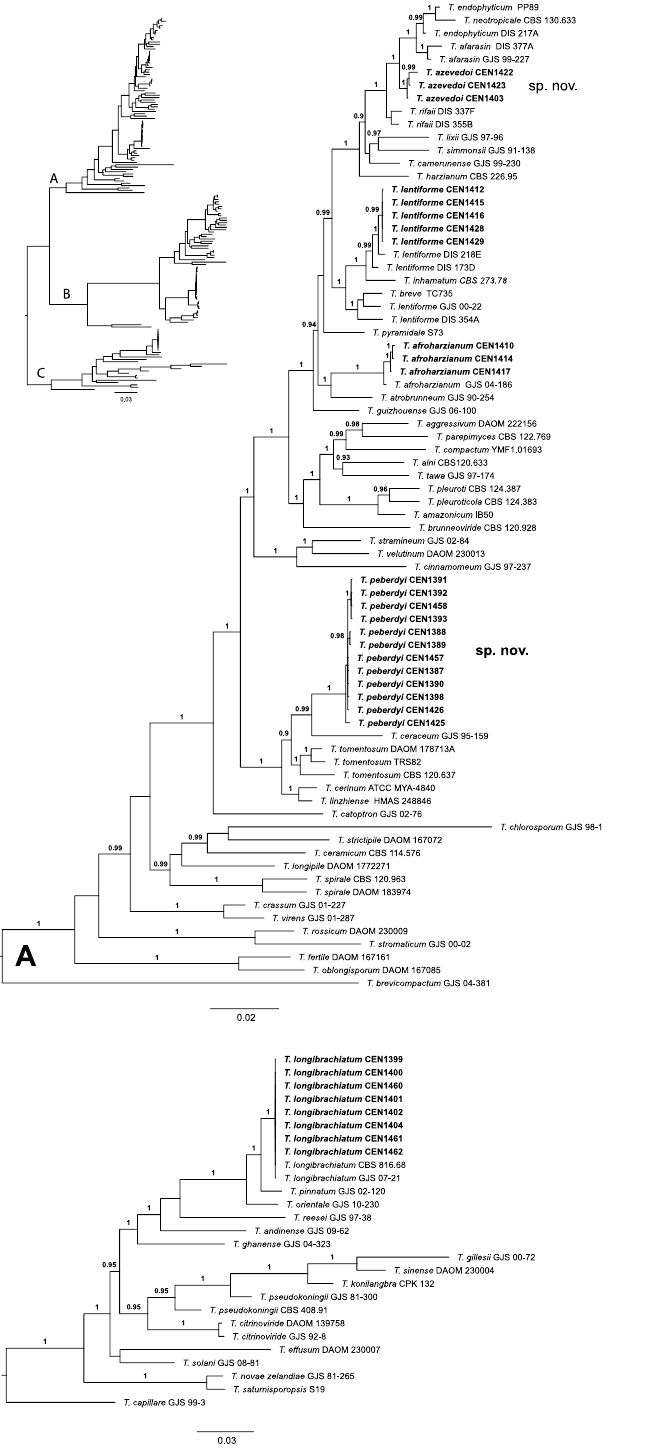
Fig 2. A-C. Midpoint rooted Bayesian phylogram (split into three parts as indicated in the overview), based on the concatenation of act , cal , ITS, rpb2 and tef1- α matrices. Posterior probabilities are given above branches ( > 0.9) and the scale bar represents expected changes per site. Strains sequenced in the present study are in bold and are followed by CENxxx numbers. Two new Trichoderma species, T . azevedoi and T . peberdyi are indicated.